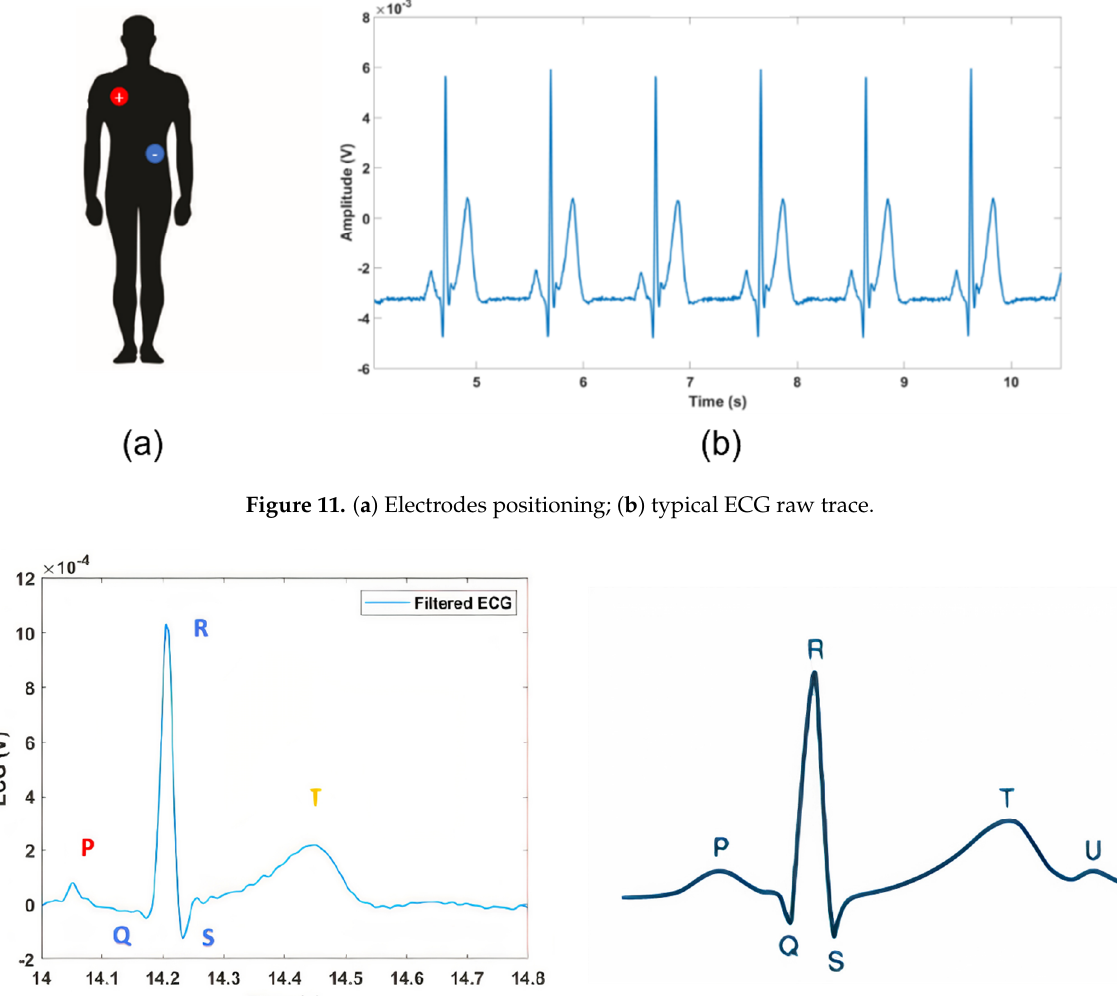
Figure 12. ( a ) Filtered ST − Qvar ECG: single oscillation; ( b ) Typical ECG, single oscillation. Table 1. ECG time intervals and amplitude ratio: nominal vs. ST-Qvar values. Table 1. ECG time intervals and amplitude ratio: nominal vs. ST-Qvar